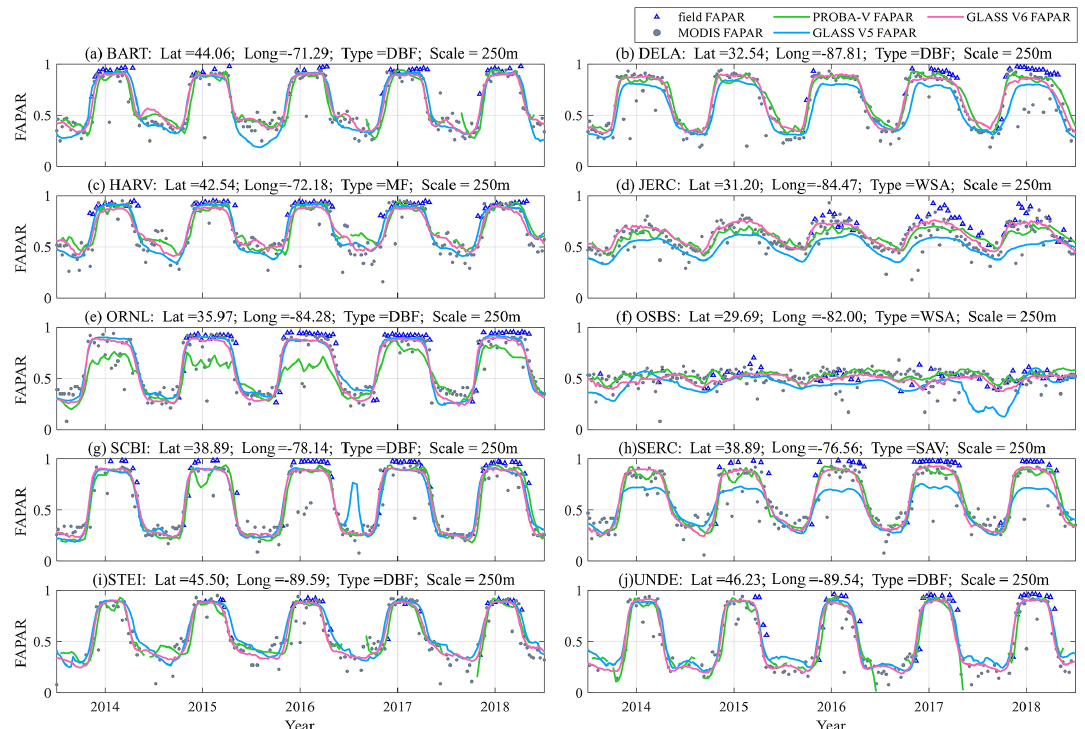
Figure 10. Time series of FAPARs from the MODIS 500m, GLASS V5 500m, GLASS V6 250m, and PROBA-V 300m products at 10 NEON sites during 2014–2018.